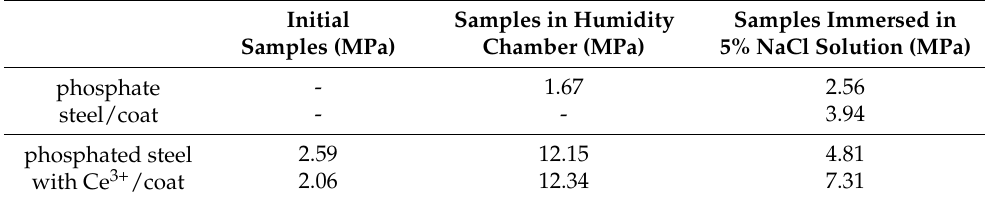
Table 10. Pull-off adhesion test of the top coating on the phosphate steel and phosphate steel with Ce 3+ ions: initial state, samples exposed to humidity conditions for 7 days and samples immersed in sea water for 48